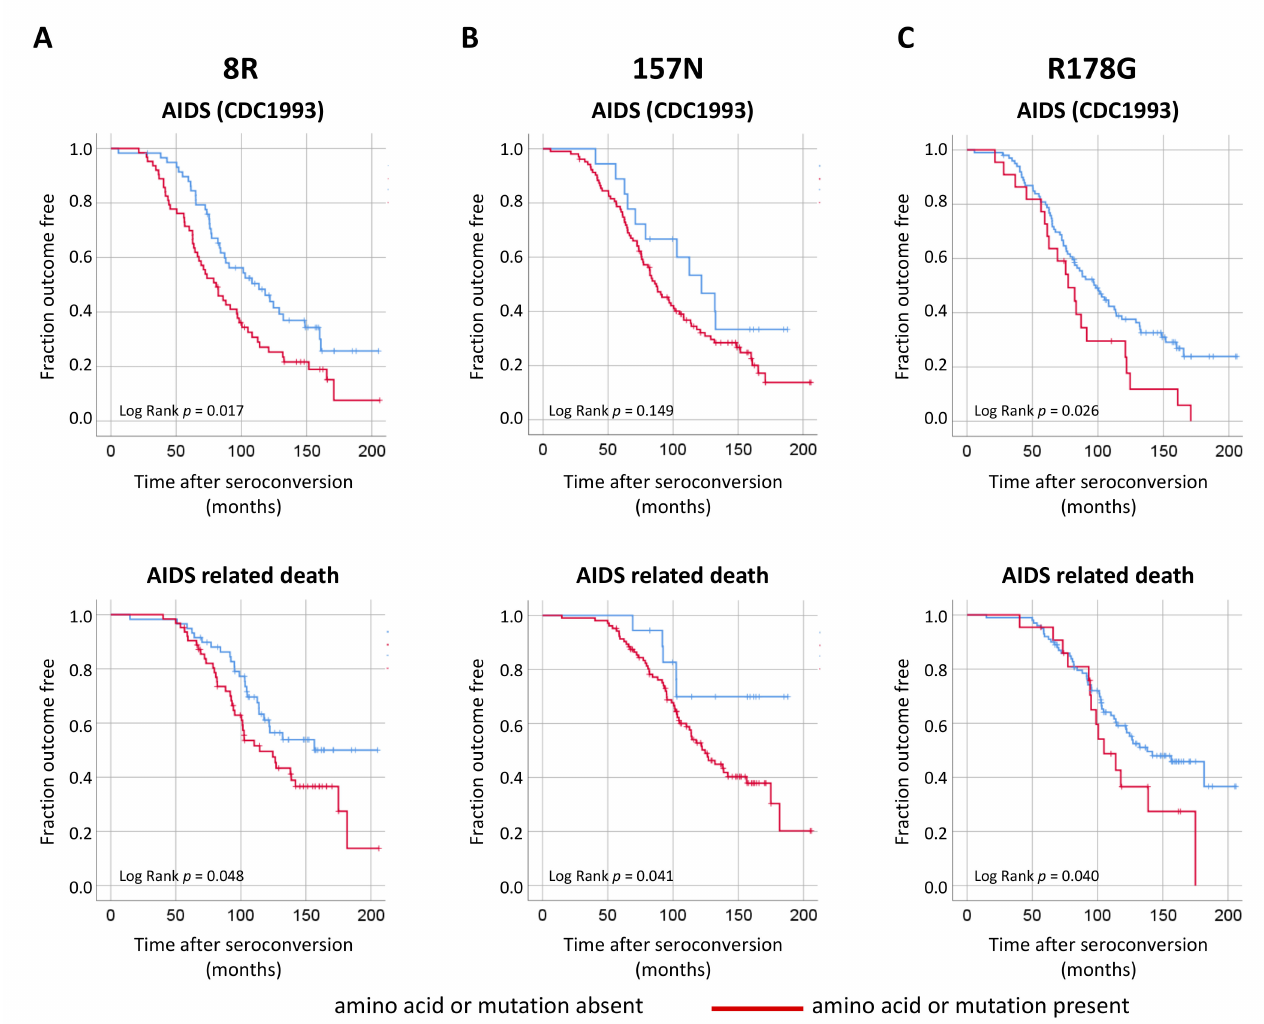
Figure 6. Effect of naturally occurring mutations in Nef on disease progression. Kaplan–Meier survival analysis for amino acid variations or mutations 8R ( A ), 157N ( B ) and R178G ( C ) in Nef with time in months from seroconversion to progression to AIDS as defined by the CDC definition 1993 (top panel) or AIDS-related death (bottom panel). P values displayed represent log-rank